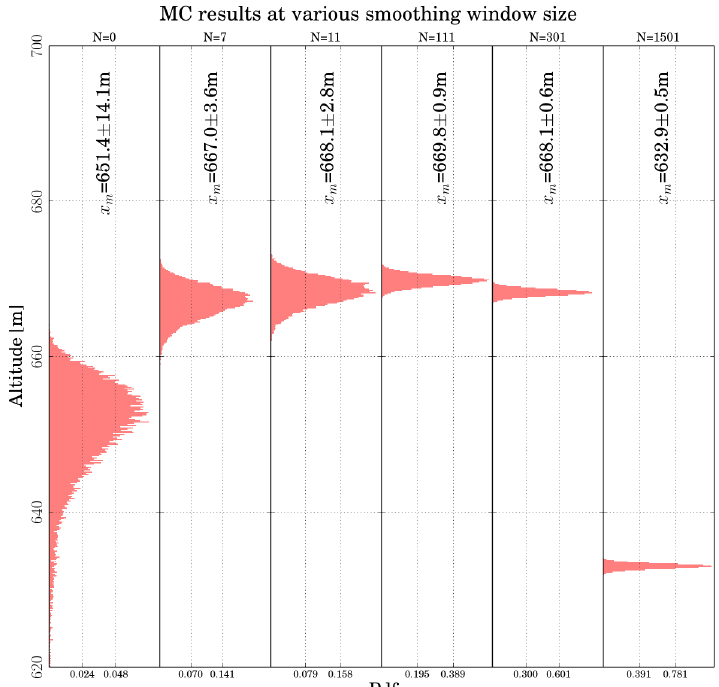
Figure 7. Probability density functions of six MCs performed 100000 times each. For this example we used a fixed spatial resolution of 0.1m. The different smoothing window with size N is indicated at the top of each panel, and the median of the distribution x m and its localization error as defined in Eq. (7) are